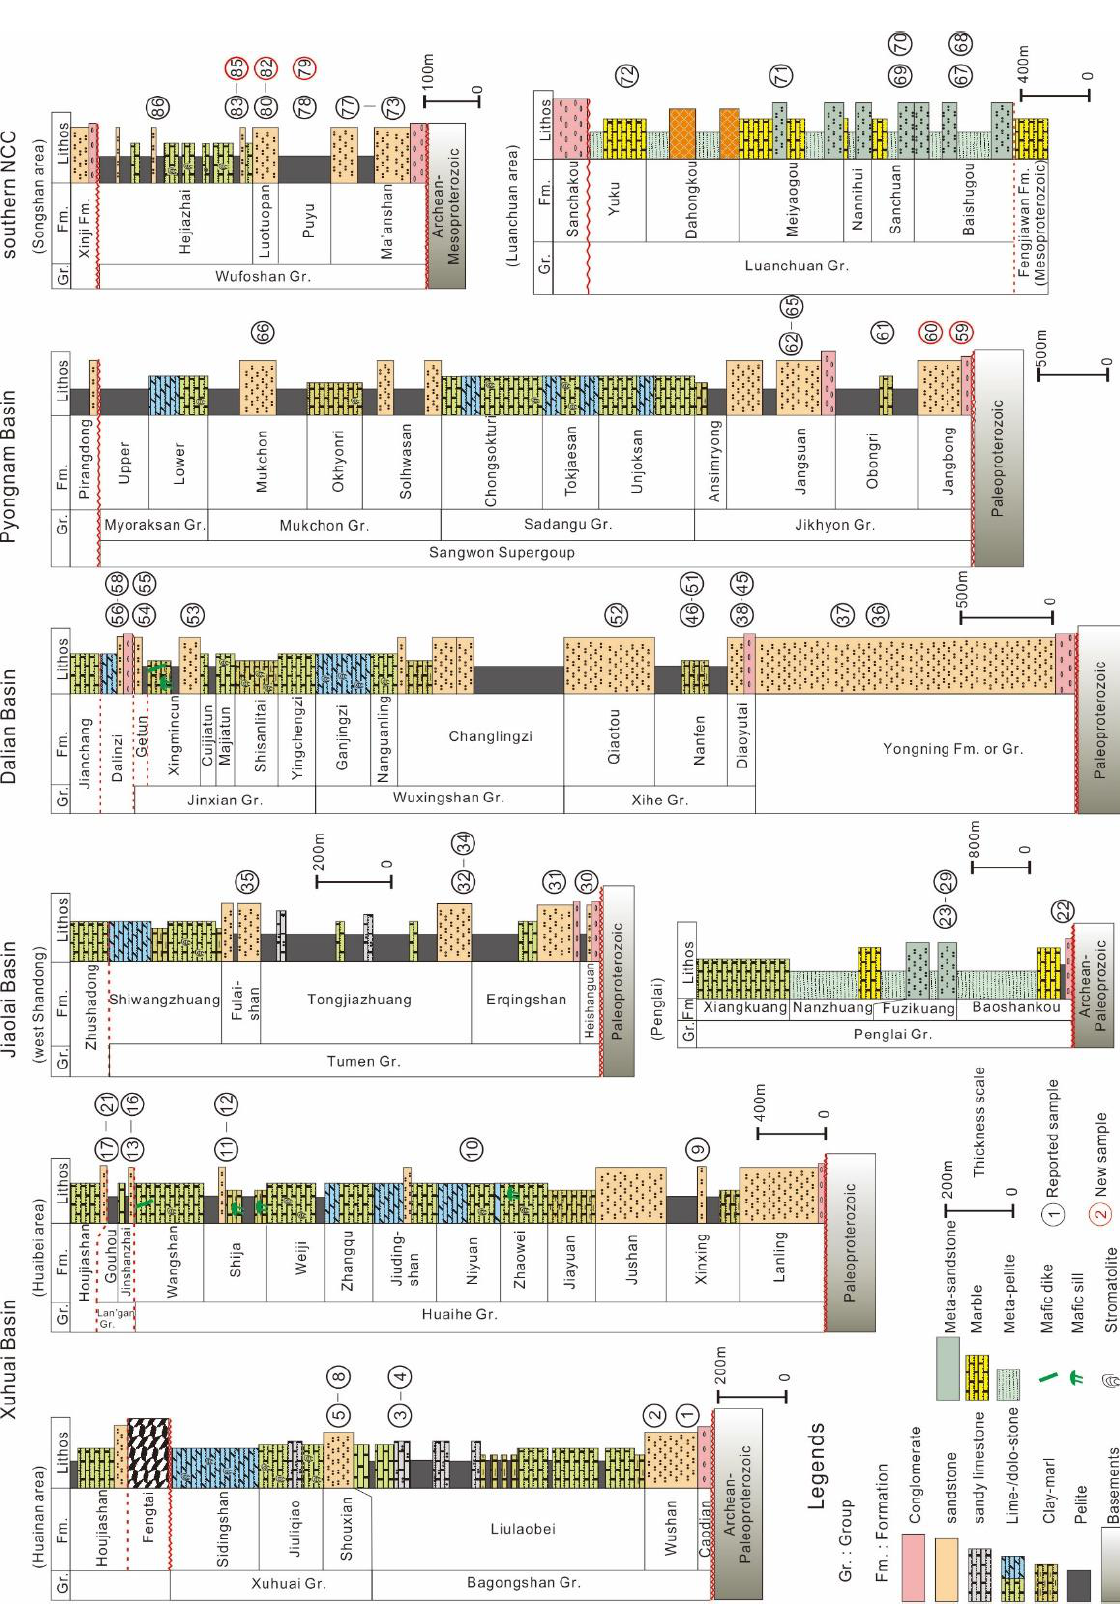
Figure 3. Stratigraphy of the late Meso- to early Neoproterozoic successions in south–southeast NCC [42 – 44]. The reported samples are from [17 – 24,44 – 49].